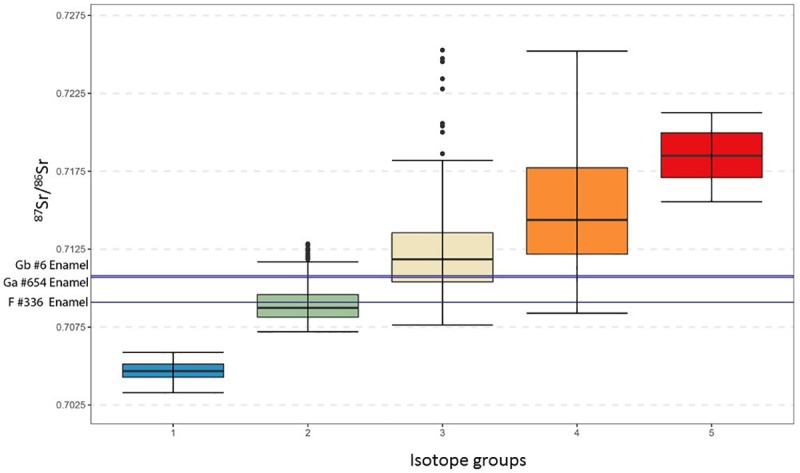
Box and Whisker plot of the isotope groups of France [76] with lines indicating the enamel 87Sr/86Sr values for the Payre samples.